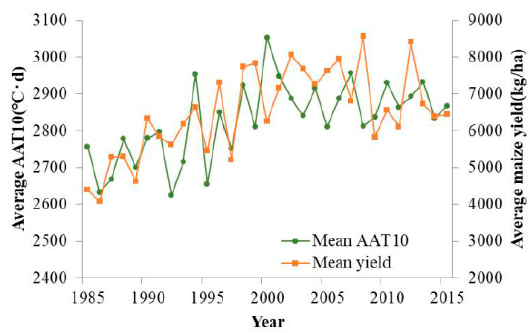
Figure 4. Temporal changes of ≥ 10 °C accumulated temperature (AAT10) and yield.